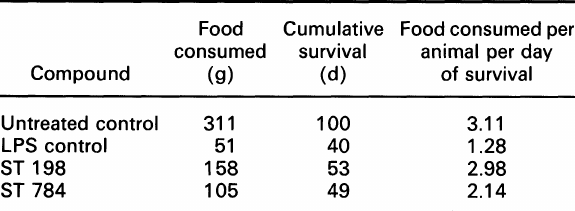
Mice (ten animals per group) were treated with ST 198 (50 mg/kg, i.p.) and with ST 784 (50 mg/kg, i.p.), twice daily but once at day 0, starting from day -1 to day + 3, with respect to the LPS challenge (day 0). Control groups were either injected with 30 mg/kg LPS (LPS control) or treated twice a day with saline from day through day + 3 (untreated control). Animals were followed up to 10 d after LPS injection. Food consumed during this time as well as cumulative survival (referred to as the sum of the days of survival of each single mouse within a group) were evaluated. The ratio of the former and the latter parameter yields the food consumed per animal per day of survival (right-end column).